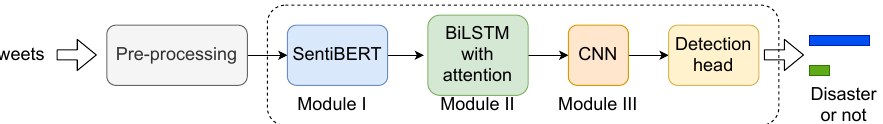
Figure 1. The proposed SentiBERT-BiLSTM-CNN learning pipeline for disaster prediction us- ing